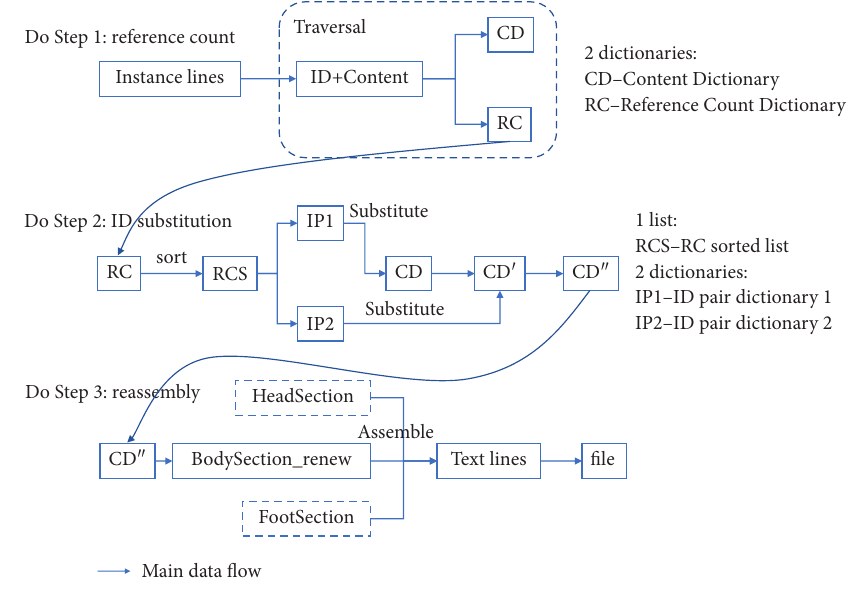
Figure 8: Data flowchart for instance reordering of